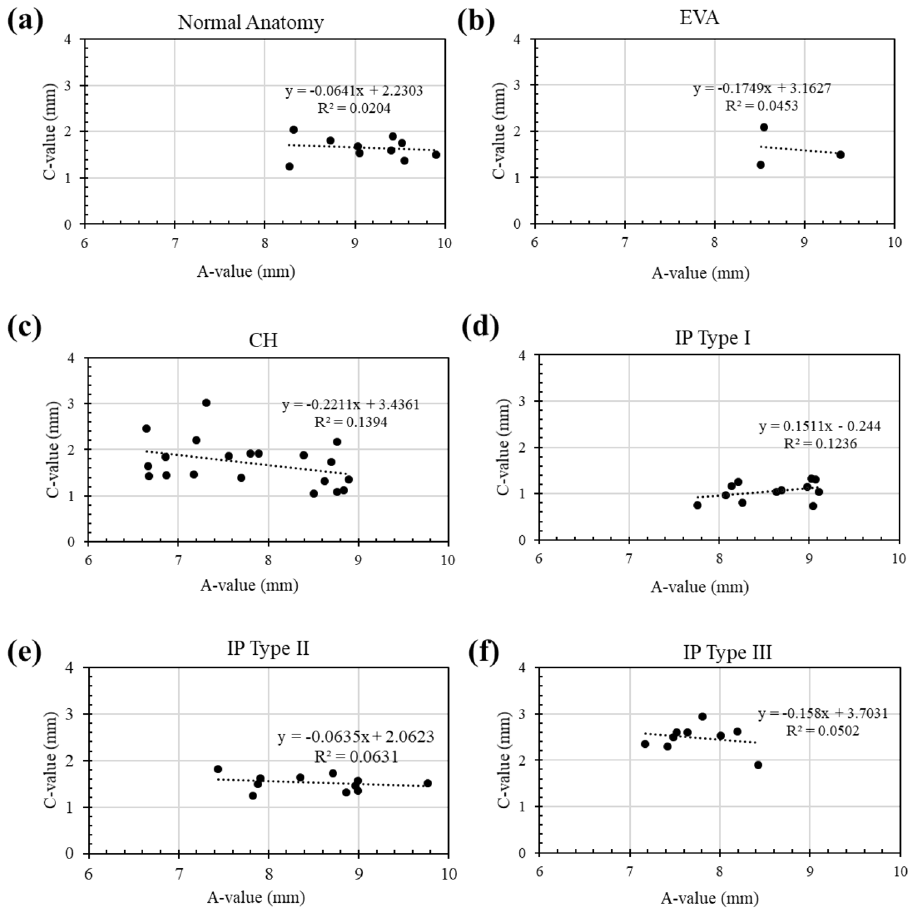
Figure 5. Plots of regression of A- versus C- value of normal anatomy ( a ), EVA ( b ), CH ( c ), IP type I ( d ), IP type II ( e ), and IP type III ( f ) captured from CT images used in this